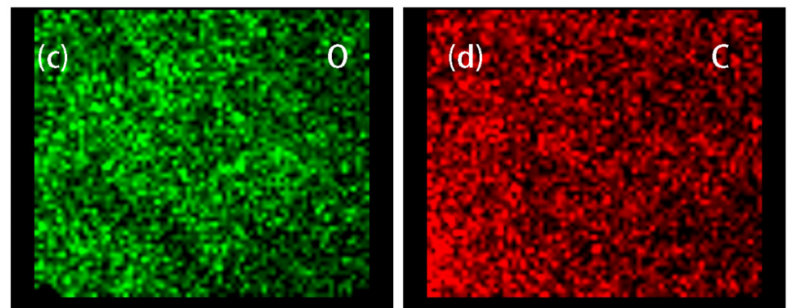
Figure 1. ( a ) SEM images of Graphene /Fe 3 O 4 ; ( b – d ) iron, oxygen, and carbon mapping images of Graphene/Fe 3 O 4 .